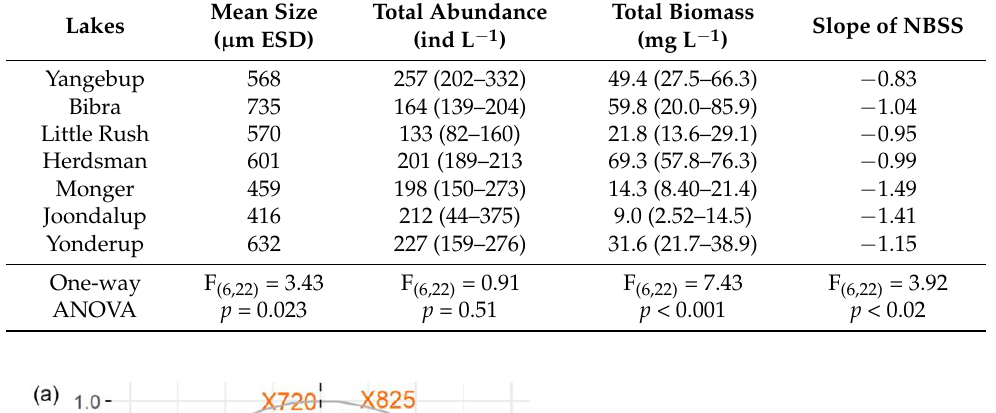
Table 4. Summary of zooplankton community size structure in the seven urban lakes; values are given as the average with minimum and maximum values shown in parentheses. ESD = equivalent spherical diameter; NBSS = normalised biomass size spectra.